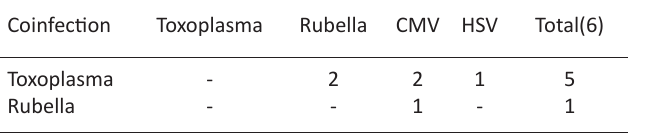
Table 4. Coinfection among TORCH pathogens Coinfection Toxoplasma Rubella CMV HSV Total(6) Toxoplasma - Rubella